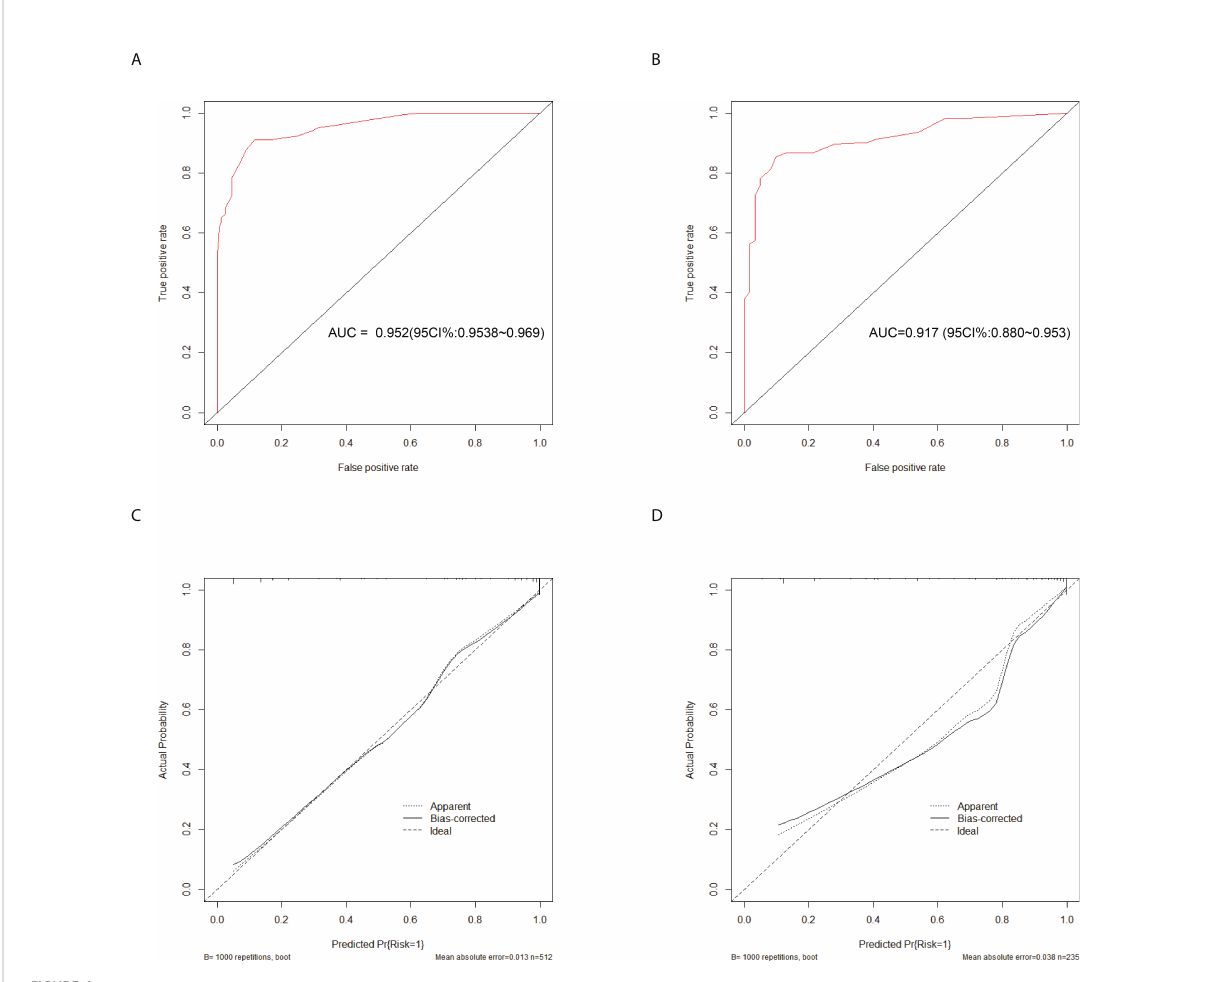
FIGURE 4 Discrimination and calibration of the scoring system for discrimination of APTB and IPTB. ROC curves of the scoring system in the training cohort (A) and validation cohort (B) . Calibration curves of the scoring system in the training cohort (C) and validation cohort (D)